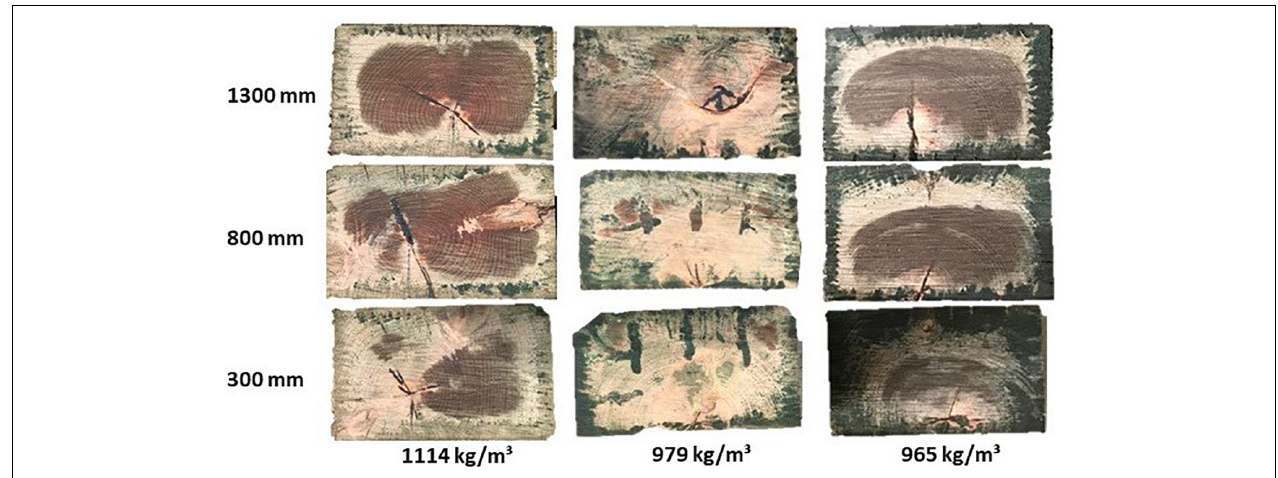
FIGURE 13 | Penetration of the alternative oily preservative in sleepers at different gross weights (1,114; 979; and 965 kg/m 3 ) at 300, 800, and 1,300